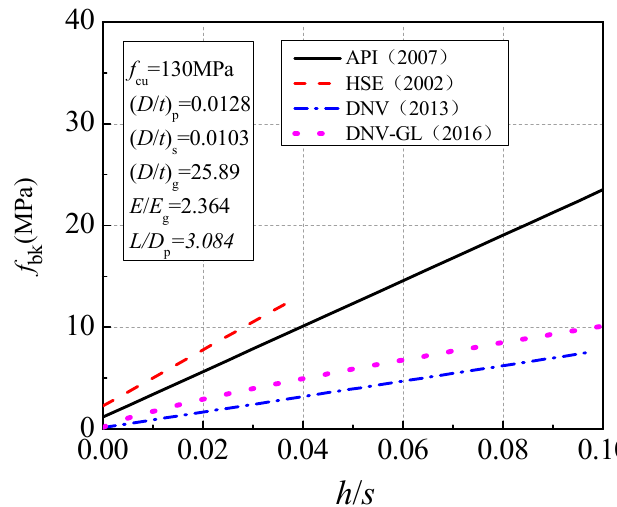
Figure 4. Relationship between interface shear strength ( f bk ) and height-to-distance ratio of shear key ( h / s ).